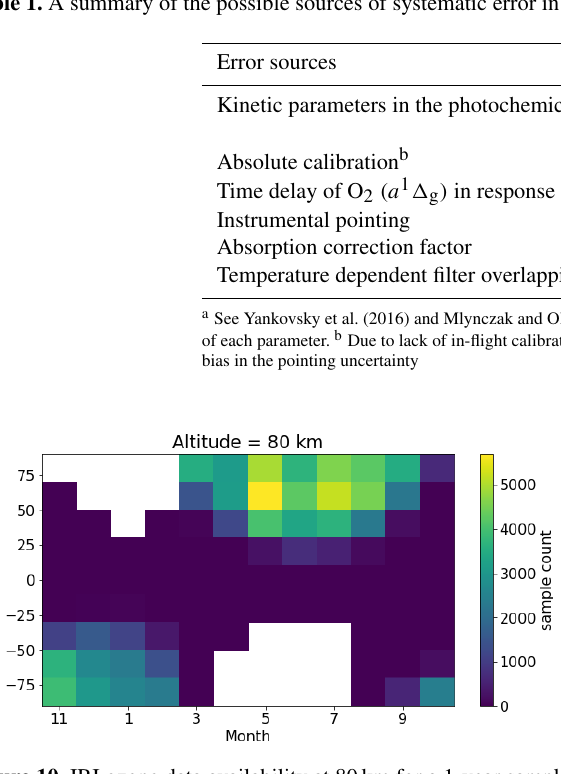
Figure 10. IRI ozone data availability at 80km for a 1-year sample dataset (every 20th orbit), after validity criteria have been applied (see text). The number is expected to increase by 20 times when all the orbits of 1 year are